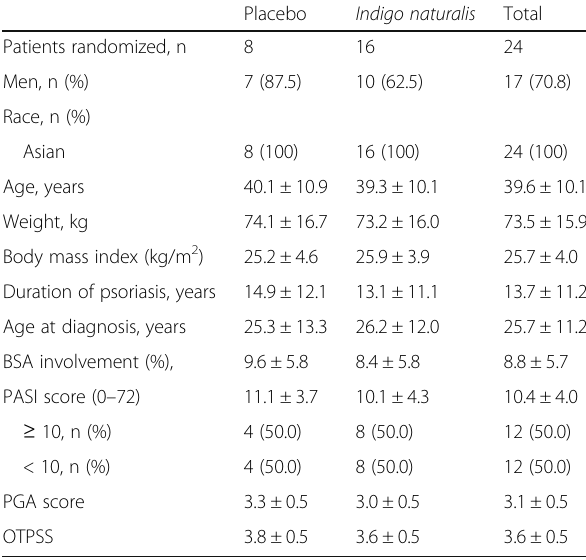
Table 1 Baseline demographics and disease